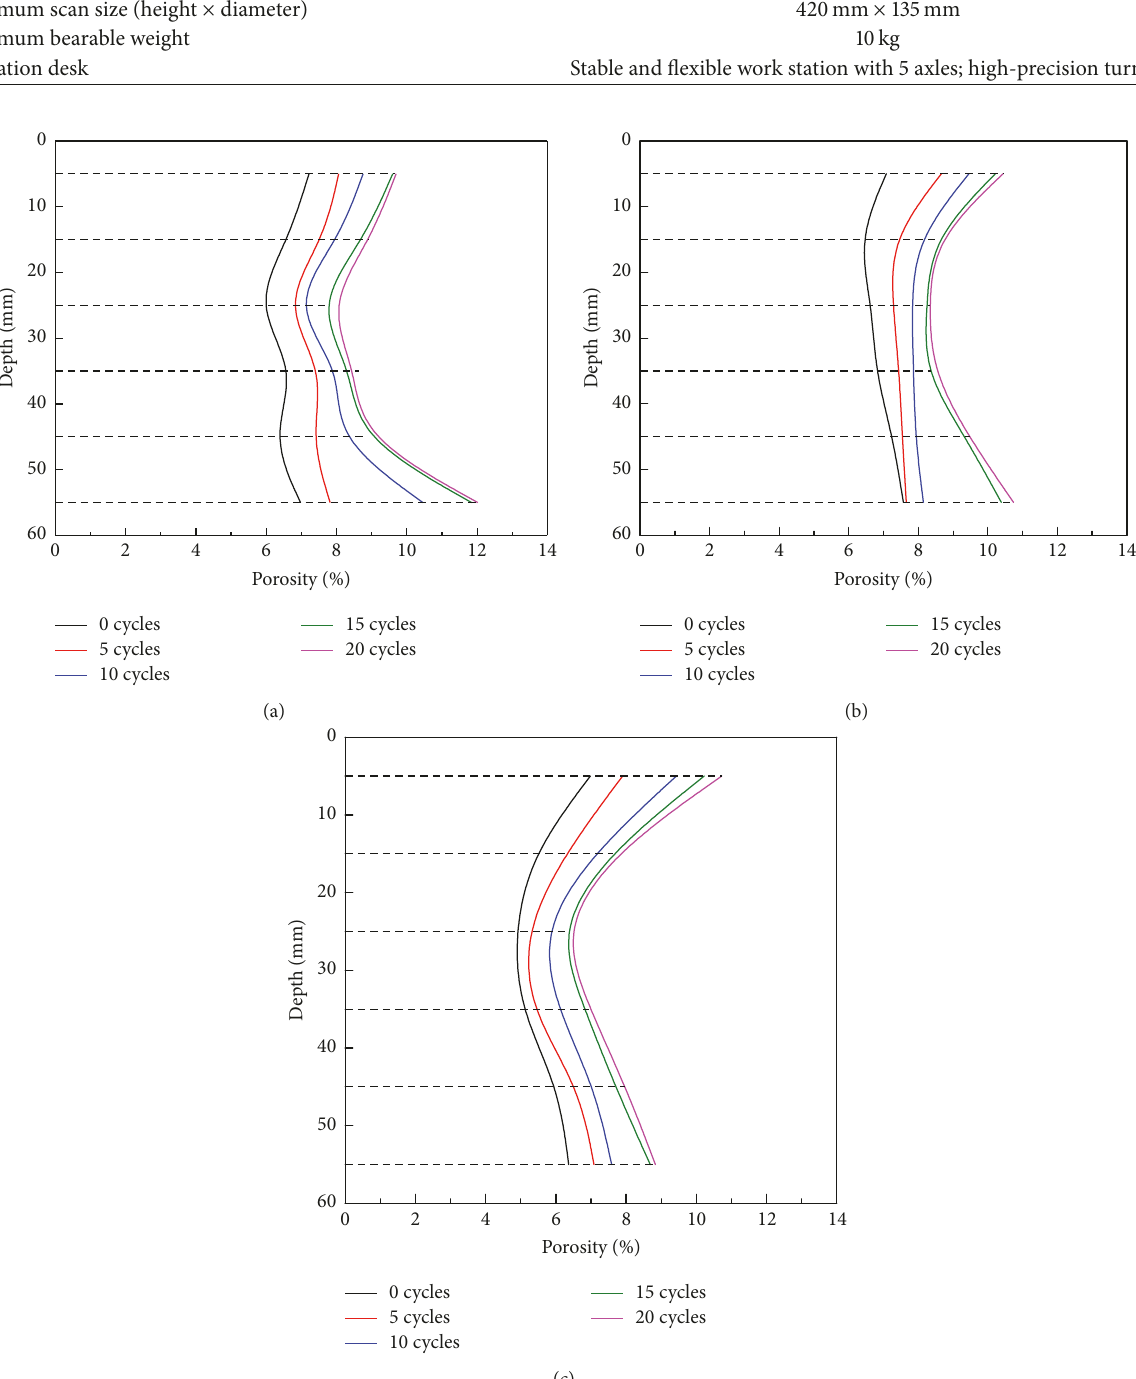
Figure 4: Porosity distributions of the different samples after 90 d of curing: (a) cement content = 4.0%; (b) cement content = 4.5%; (c) cement content =